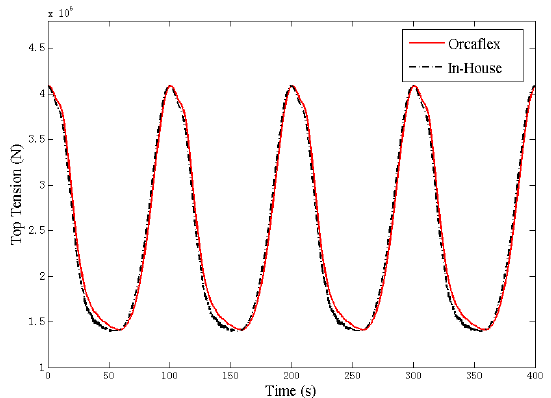
Figure 11. Multicomponent mooring line under the horizontal harmonic excitation.